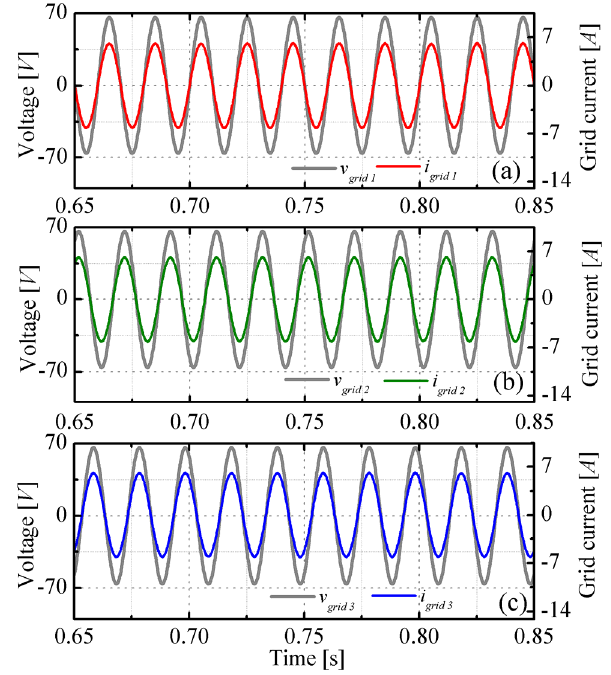
Figure 6. Sunny case: time behavior of the output currents compared to the grid voltages related to ( a ) phase 1; ( b ) phase 2; and( c ) phase 3.